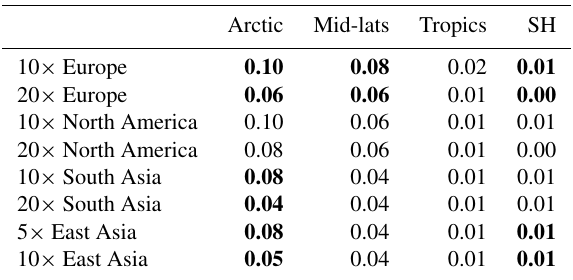
Table 2. Surface temperature change per global BC emissions (in K per Tgyr − 1 ). Bold numbers represent statistically significant dif- ferences between the emission rates (using 10 vs. 20 or 5 vs. 10 for East Asia).